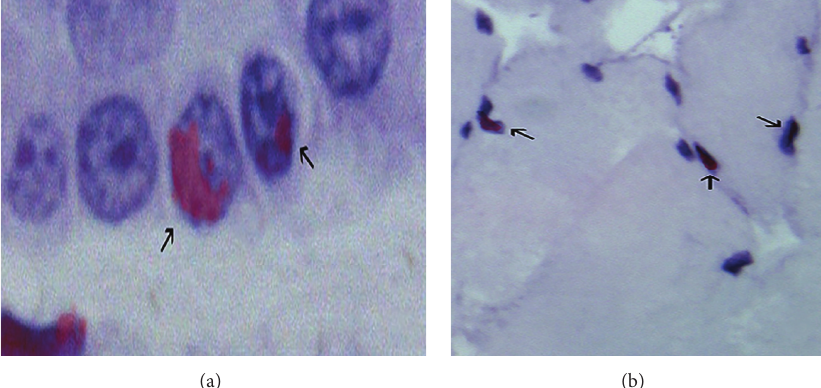
Figure 3: Epithelial differentiation of Dil labeled MSCs (a). Muscle cell differentiation of transplanted bone marrow derived Dil labeled MSCs